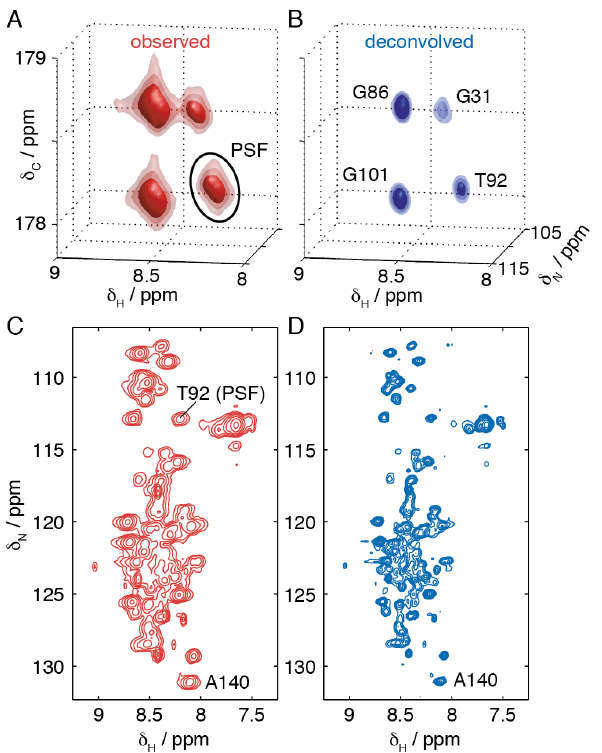
Figure 1. Multidimensional deconvolution of in-cell NMR spectra. HNCO spectra of a Syn (A) expressed within E. coli cells and (B) following deconvolution using the T92 reference peak indicated in (A). (C,D) 1 H/ 15 N projections of (C) the original HNCO spectrum and (D) the spectrum following deconvolution.